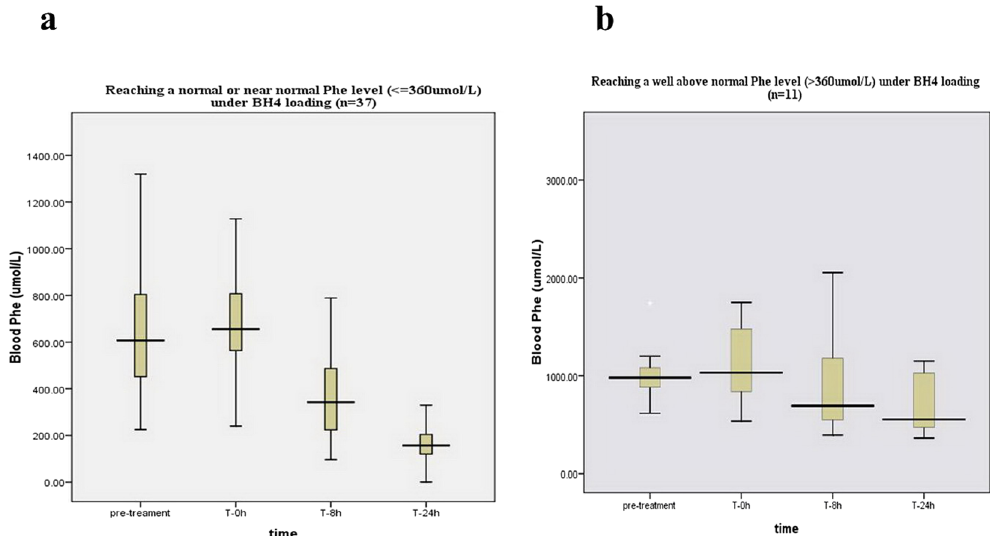
Figure 1. The length of the boxes indicates the interquartile space (P25–P75); the horizontal line into the box represents the median (P50), and the error bars indicate the adjacent values, that is, the maximum and minimum values of the distribution, which may not be considered